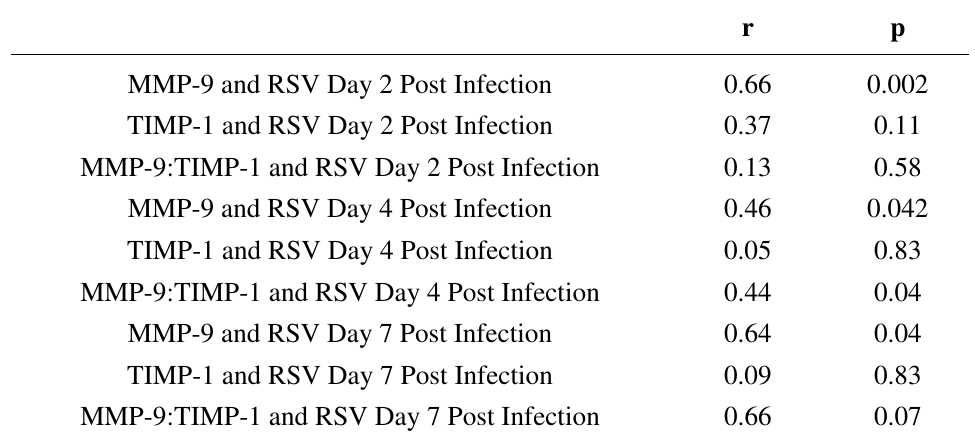
Table 1. Positive correlation between MMP-9 levels and RSV titer in wild-type C57BL/6